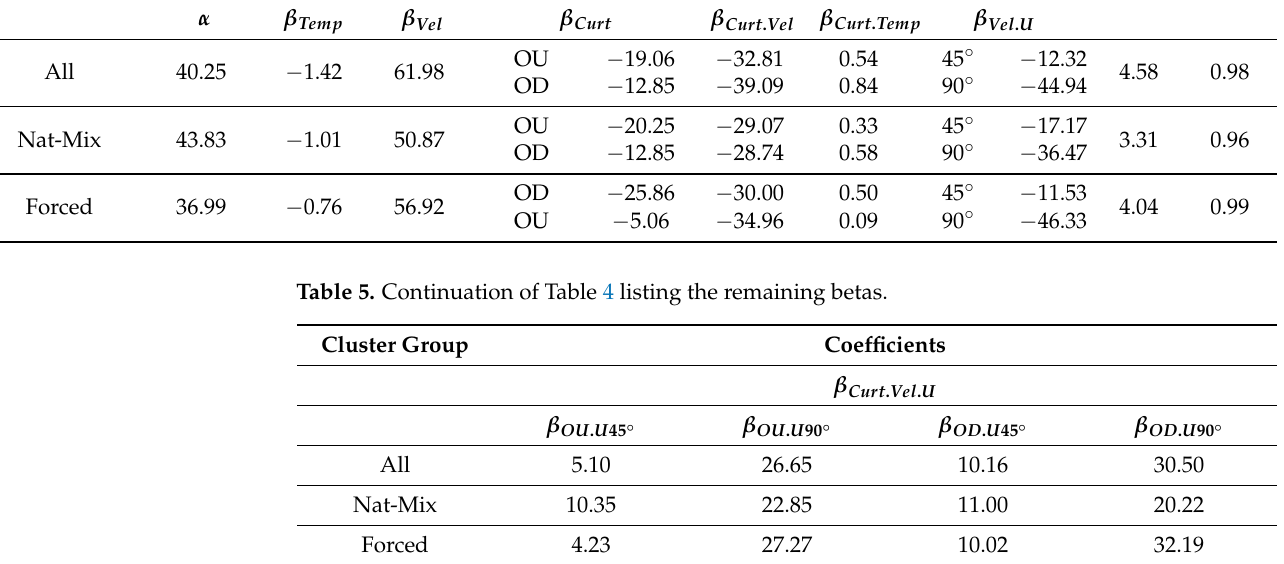
Table 4. Residual standard error (RSE) and R 2 for all cluster groups and corresponding alphas and first part of the betas. Cluster Group Coefficients